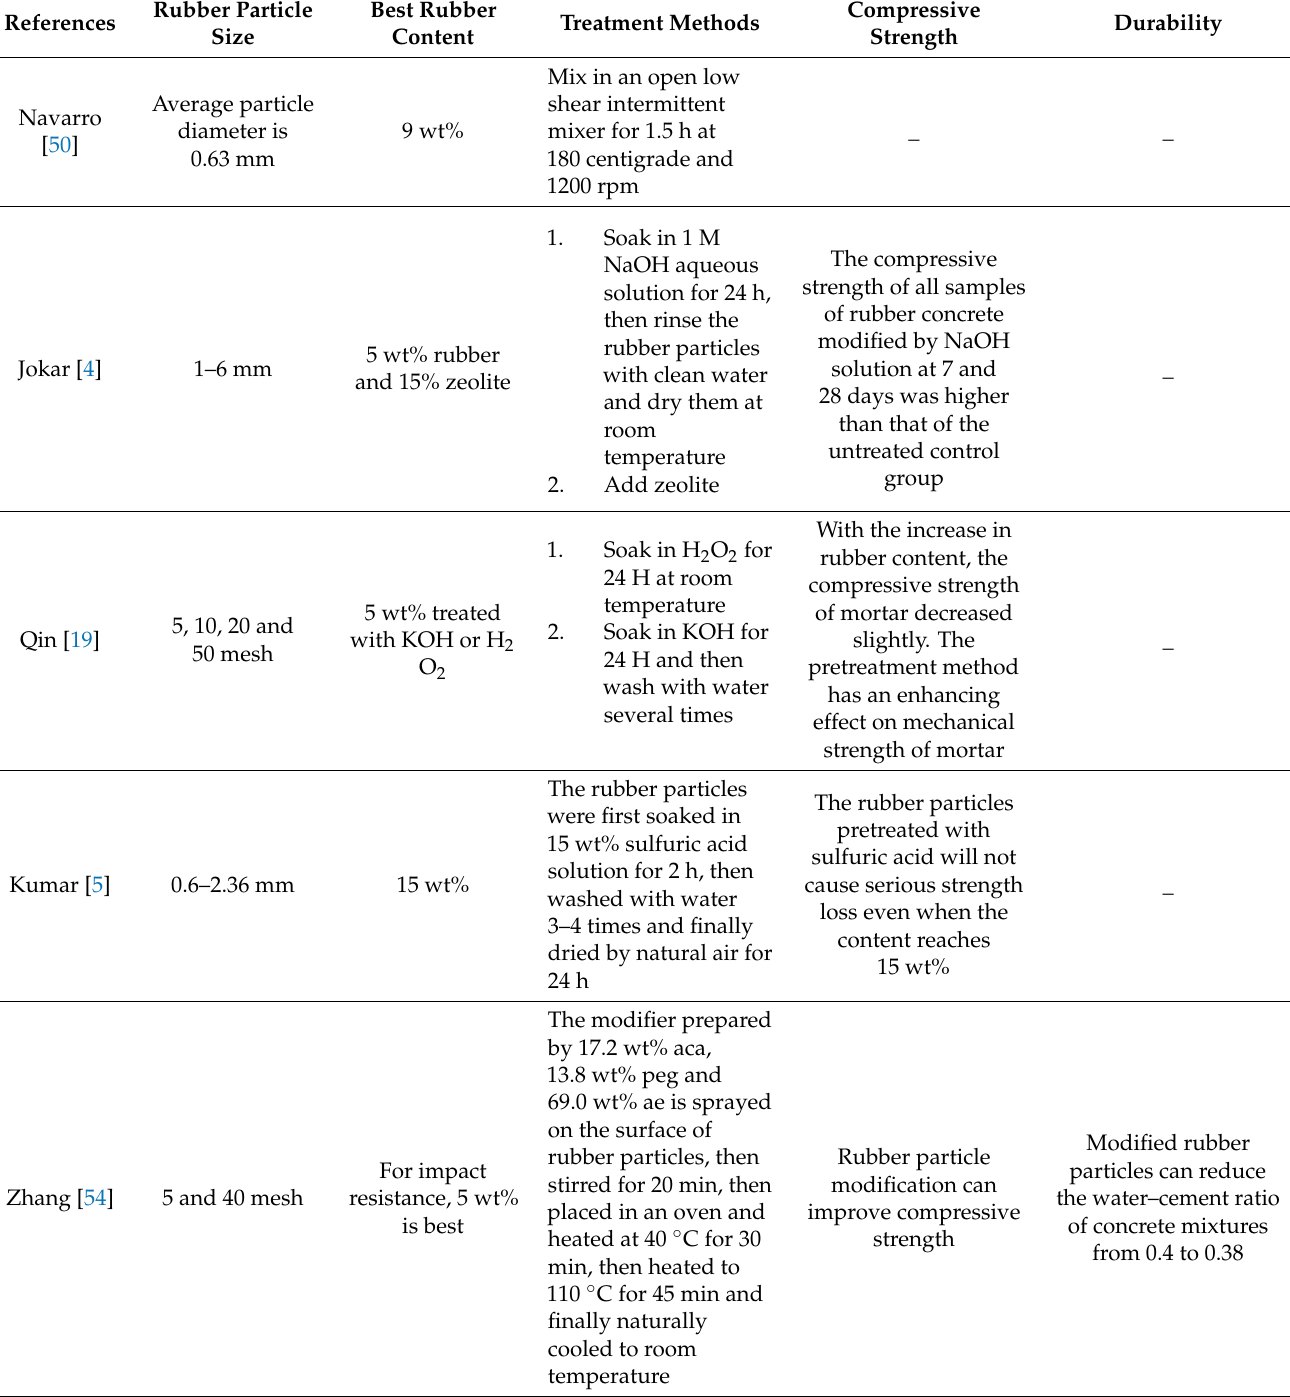
Table 6. Summary table of rubber